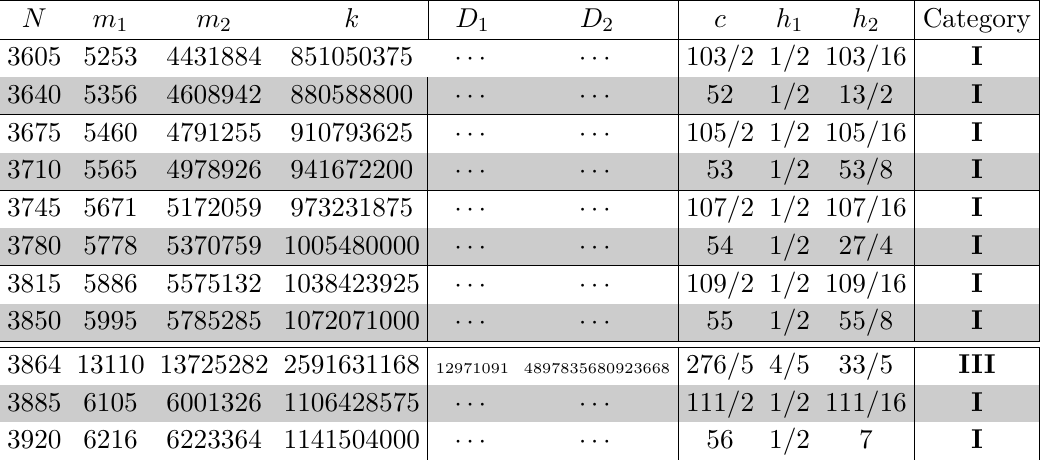
Table 18 . Solutions to the [ 3 , 0 ] MLDE with 51 < c ≤ 56 .